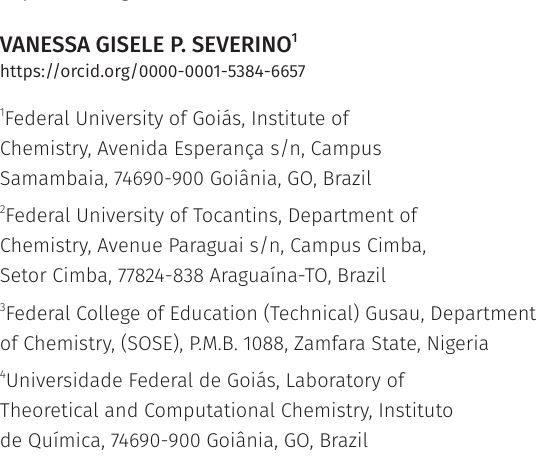
Figure S1. MS/MS spectral pattern of 3’,4’,5,7-tetrahydroxyflavone. Figure S2. MS/MS spectral pattern of 4’,5,7-trihydroxyflavanone. Figure S3. MS/MS spectral pattern of 3,4,5-trihydroxybenzoic acid. Figure S4. MS/MS spectral pattern of 2-(3,4-dihydroxyphenyl)-3,5,7-trihydroxy-4H-chromen- 4-one. Figure S5. MS/MS spectral pattern of 3-{[6-O-(6-deoxy- α-L-mannopyranosyl)-β-D-glucopyranosyl]oxy]}-2-(3,4- dihydroxyphenyl)-5,7-dihydroxy-4H-1-benzopyran-4- one. Figure S6. MS/MS spectral pattern of 2-(3,4-dihydroxyphenyl)-3-(β-D-glucopyranosyloxy)- 5,7-dihydroxy-4H-1-benzopyran-4-one. Figure S7. MS/MS spectral pattern of 2,5-dihydroxybenzoic acid. Figure S8. MS/MS spectral pattern of 2-(3,4-dihydroxyphenyl)-3,4-dihydro-2H-1-benzopyran- 3,5,7-triol. Figure S9. MS/MS spectral pattern of 3,4-dihydroxybenzoic acid. Figure S10. Principal component plots for MS data of the sub-fractions D3.7, EA7.3, EA7.6, EA7.11.1, and EA7.11.3: a) score plot for PC1 x PC2; b) loadings for PC1 x PC2. Table SI. 1H and 13C NMR spectroscopic data for compound